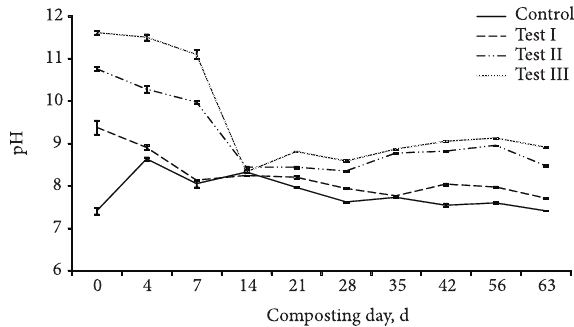
Fig. 3. The pH profile during